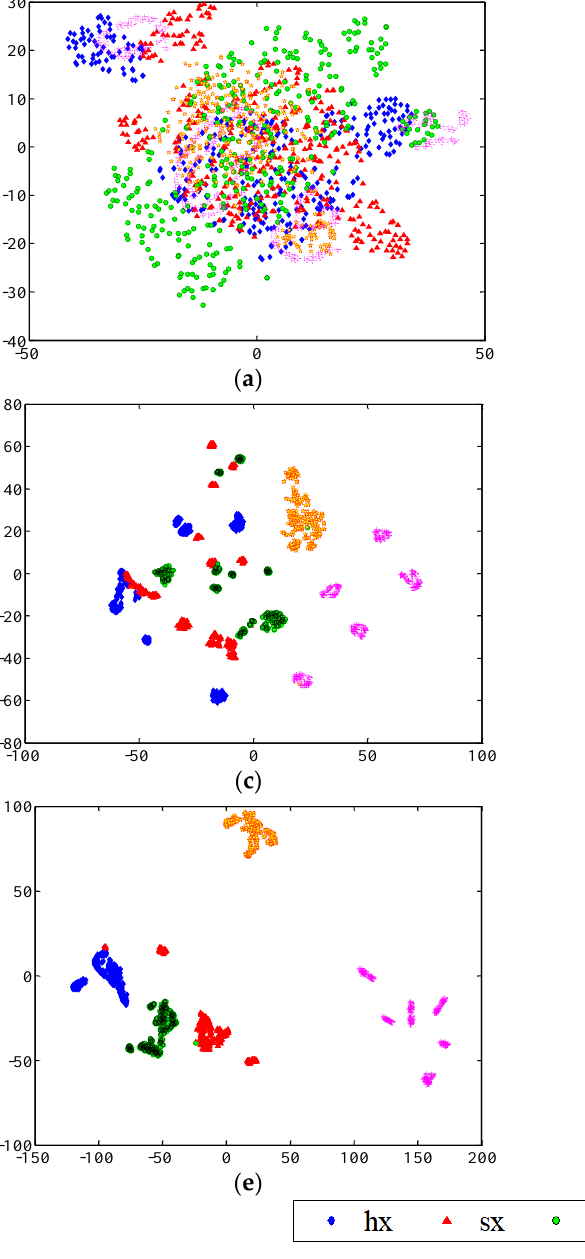
Figure 28. Visualization of feature representation via t -SNE. ( a ) Input data , ( b ) C1 , ( c ) C3 , ( d ) C5 , ( e ) FC2 , ( f ) classifier layer .